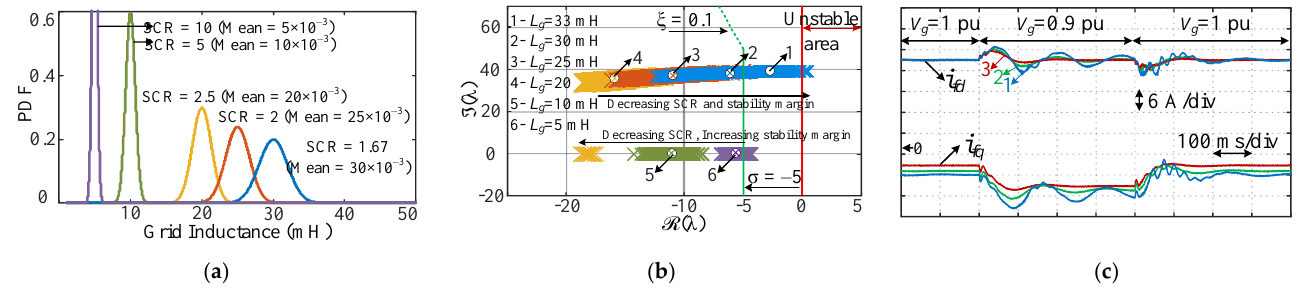
Figure 6. Probabilistic assessment and transient response of a grid-connected VSC. ( a ) Probability density functions (PDFs) of a normal distribution considering different levels of grid SCR; ( b ) critical mode locations in the complex s-plane due to considered uncertainties; ( c ) time-domain simulations showing inverter current under 10% voltage sag at grid voltage and different grid SCRs ( P = P n ); numbers indicate the operation under different grid SCRs, i.e., 1, 2, and 3 represent grid SCR equal to 1.51, 1.67, and 2, respectively.